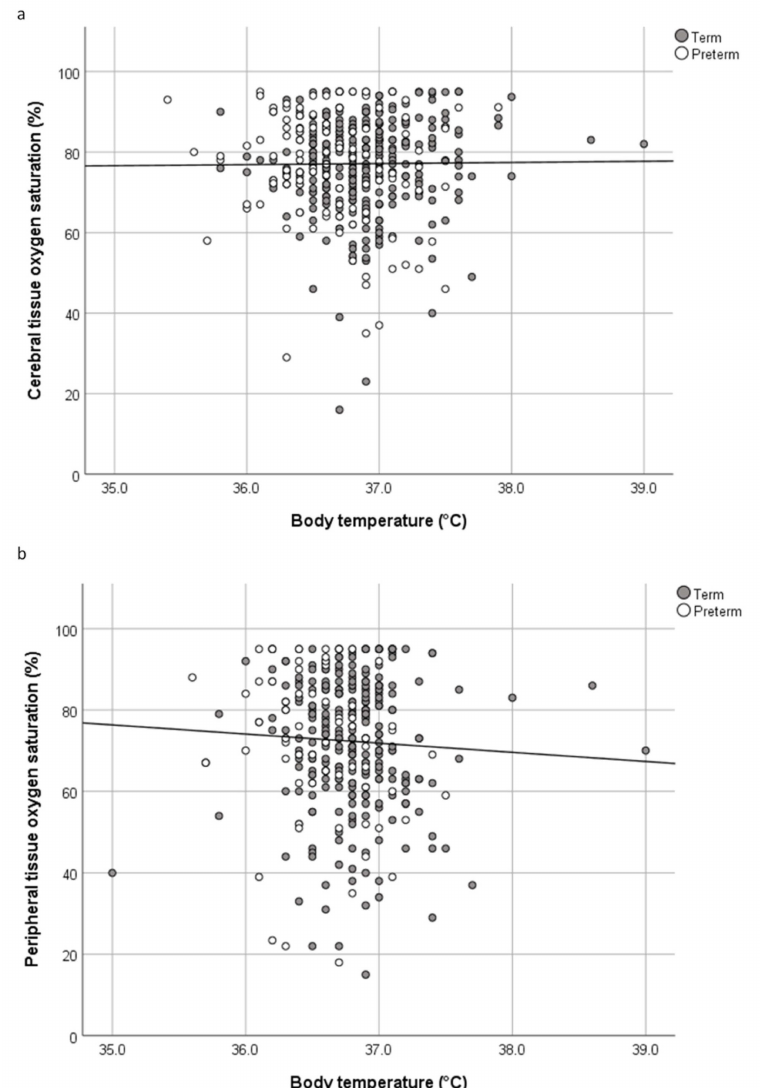
Figure 1. ( a ) Scatter plot of cerebral tissue oxygen saturation (%) and body temperature ( ◦ C) in term and preterm neonates. ( b ) Scatter plot of peripheral tissue oxygen saturation (%) and body temperature ( ◦ C) in term and preterm